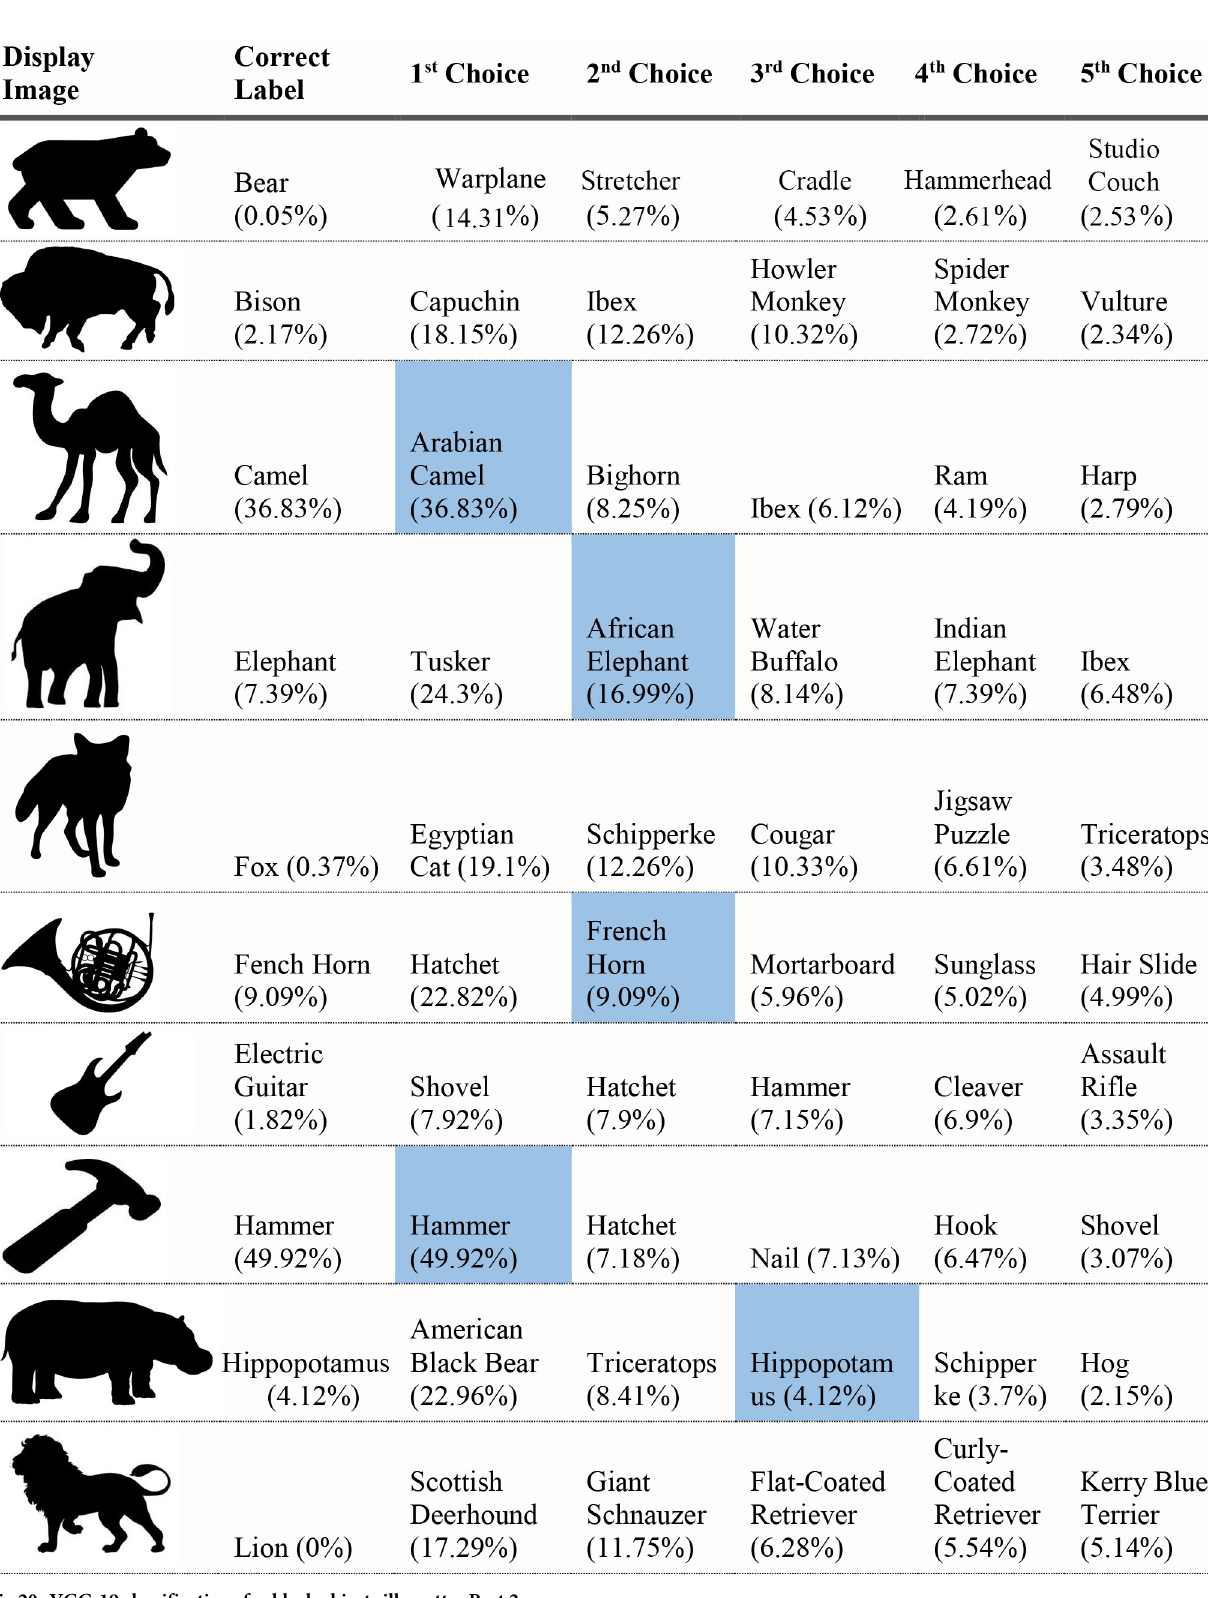
PLOS Computational Biology | https://doi.org/10.1371/journal.pcbi.1006613 December 7,